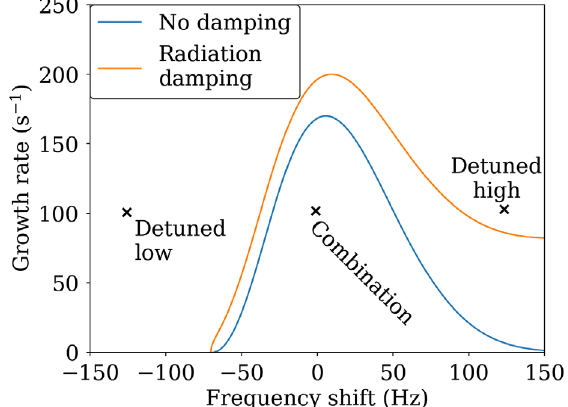
FIG. 15. Growth rates against frequency shift of coupled-bunch modes driven by two similar HOMs either detuned similarly or in opposite directions from the nearest revolution harmonic for bunches in a flattened rf potential. The points correspond to results for the three different cases while the curves are stability contours: anything below the curve is stable due to Landau